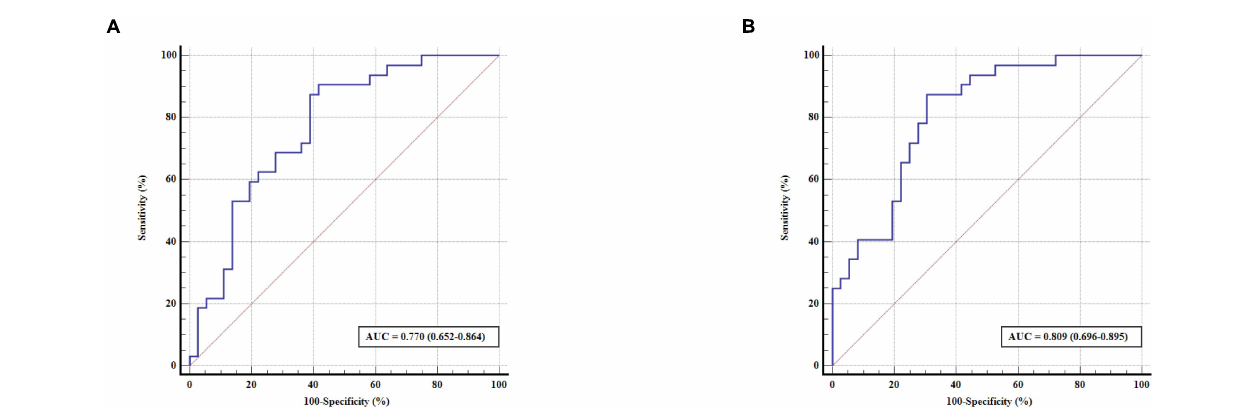
FIGURE 3 | ROC curve for predicting cognitive status in patients with PD based on the significant functional connectivity with the left PMFG (A) and right PMFG (B) .The x-axis indicates the percentage of (100 – specificity), and the y-axis indicates the percentage of sensitivity. AUC, area under the receiver operating characteristic curve; ROC, receiver operating characteristic; PMFG, posterior division of the middle frontal gyrus.